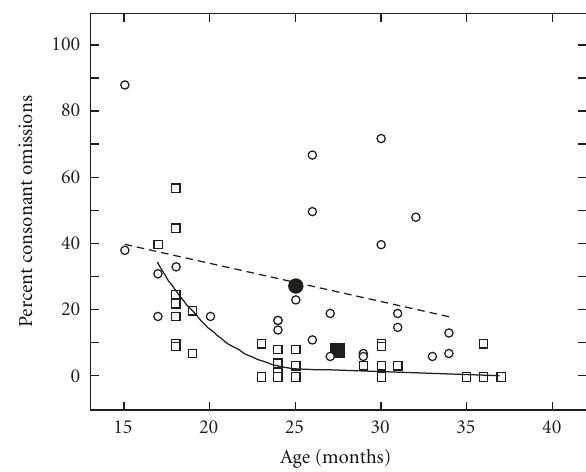
Figure 3: Number of medial and final consonants in the phonetic inventory of children with CLP (circles) and NC children (squares) across the ages of 18 to 36 months. The linear (CLP: dotted line) and curvilinear (NC: solid line) polynomials and means (filled symbols) are displayed for the groups.